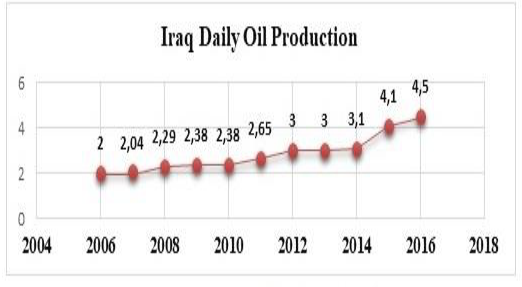
Figure 1. Iraq Daily Oil Production Source: Iraq’s Ministry of Oil